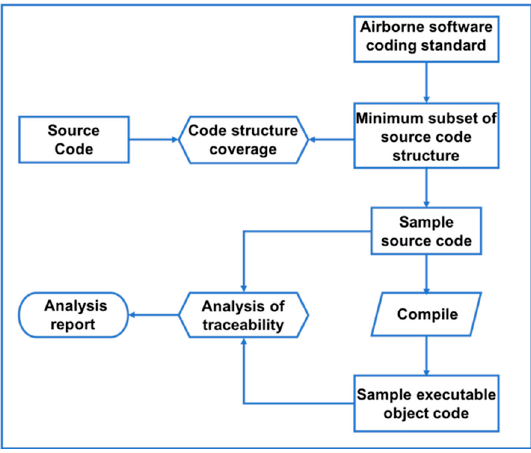
Figure 8. Analysis of minimum subset of the source code.